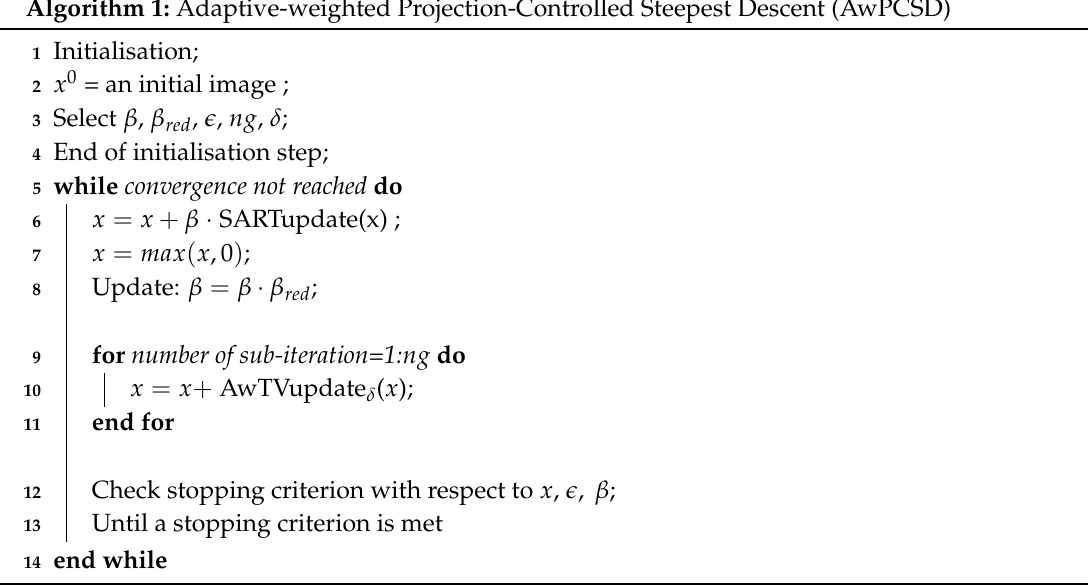
Algorithm 1: Adaptive-weighted Projection-Controlled Steepest Descent